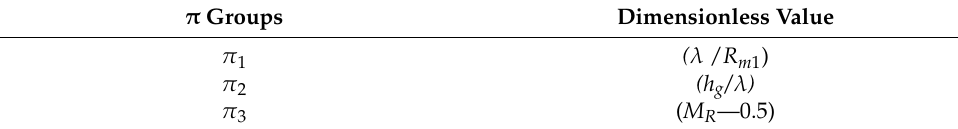
Table 1. π groups having most influence on edge conditions and interaction conditions (Dimensionless).